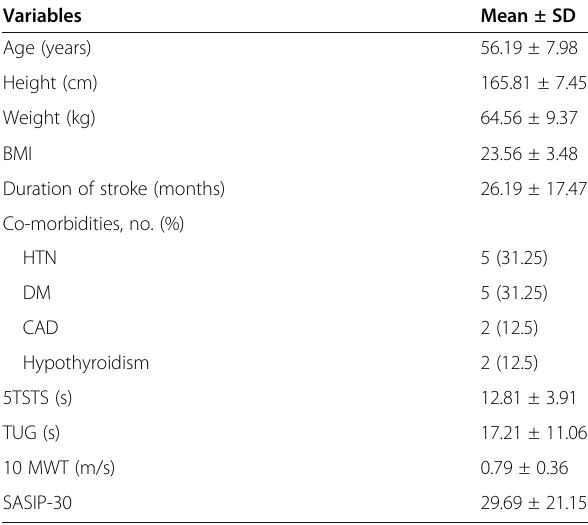
Table 1 Patient characteristics. Values are expressed in mean ± SD unless